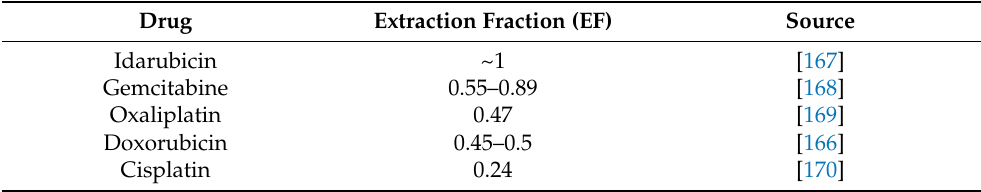
Table 2. Extraction fraction (EF) of chemotherapy agents that have been encapsulated in TSL. Drug